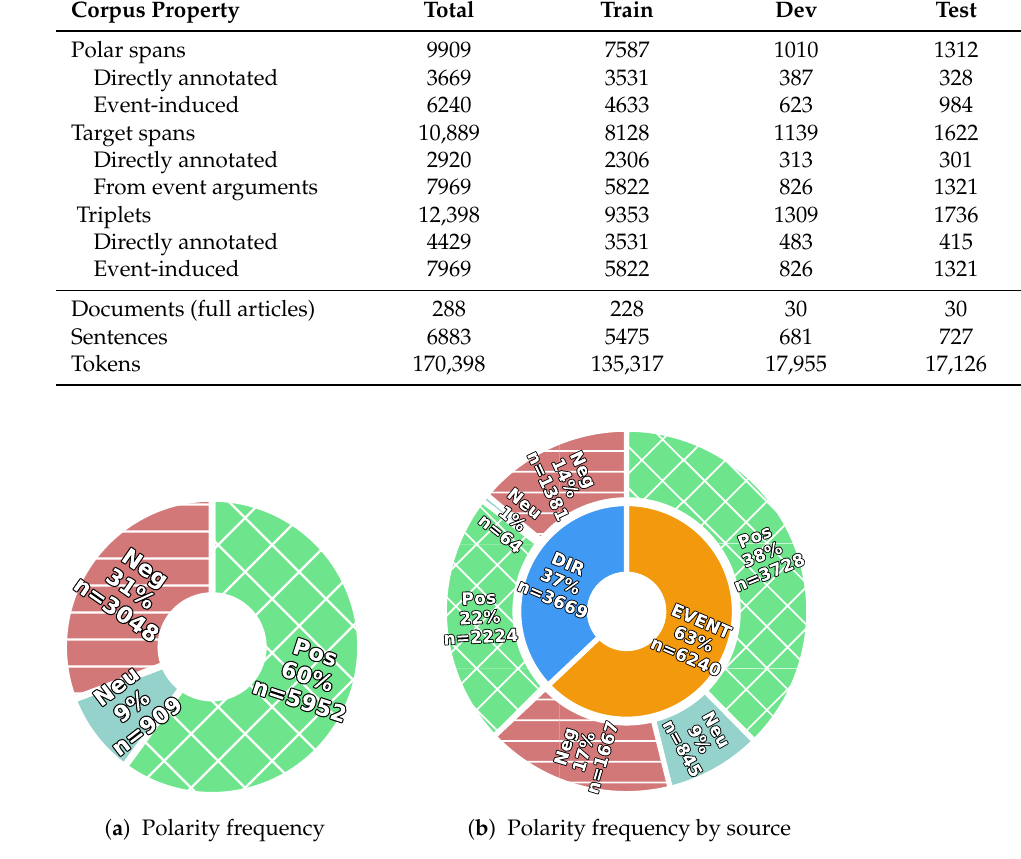
Figure 4. ( a ) Total frequency of positive (Pos), neutral (Neu), negative (Neg) polarity, and ( b ) polarity subcategorized by event-induced (EVENT) or directly-annotated (DIR) polar